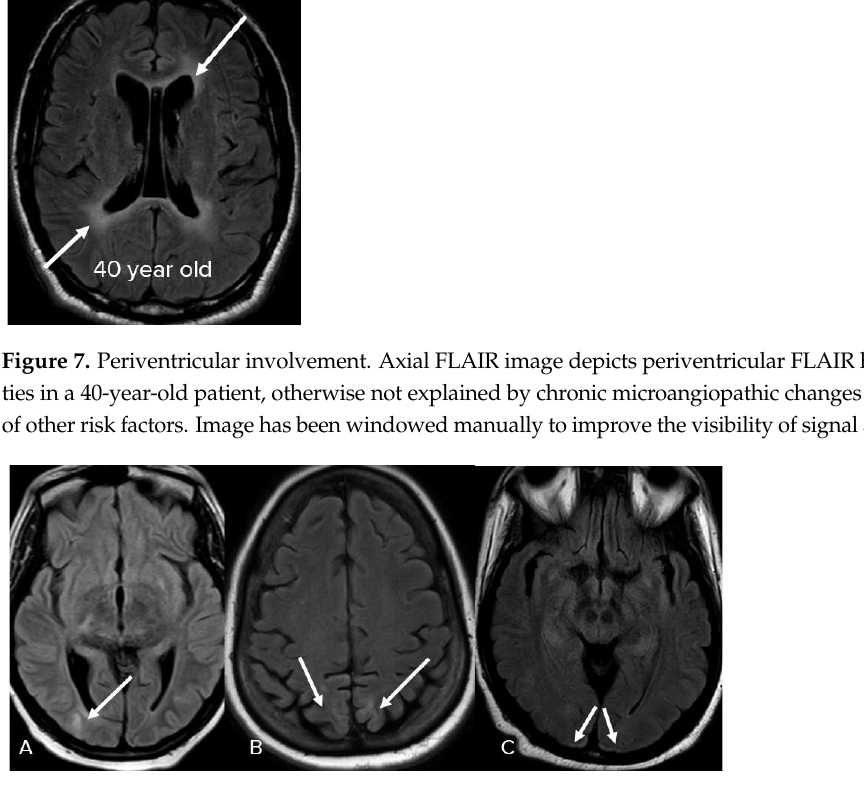
Figure 8. Cortical involvement. ( A ) Axial FLAIR images demonstrate isolated cortical-based FLAIR hyperintensity in the right occipital lobe. ( B ) Bilateral parietal FLAIR hyperintensities. ( C ) Bilateral occipital FLAIR hyperintensities. Image has been windowed manually to improve the visibility of signal abnormality.